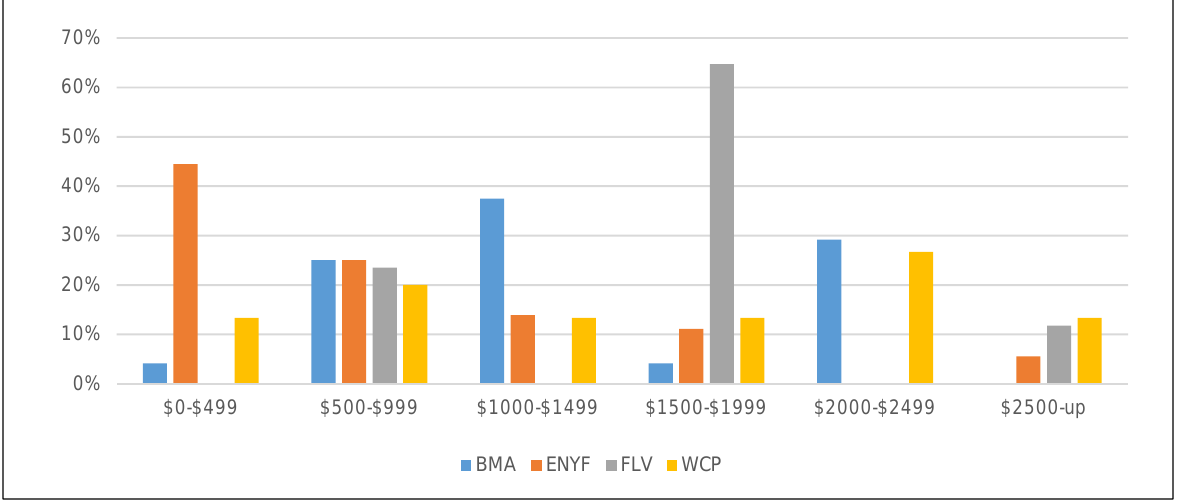
Chart 1. Percentage of Minigrants Issued in Each Size